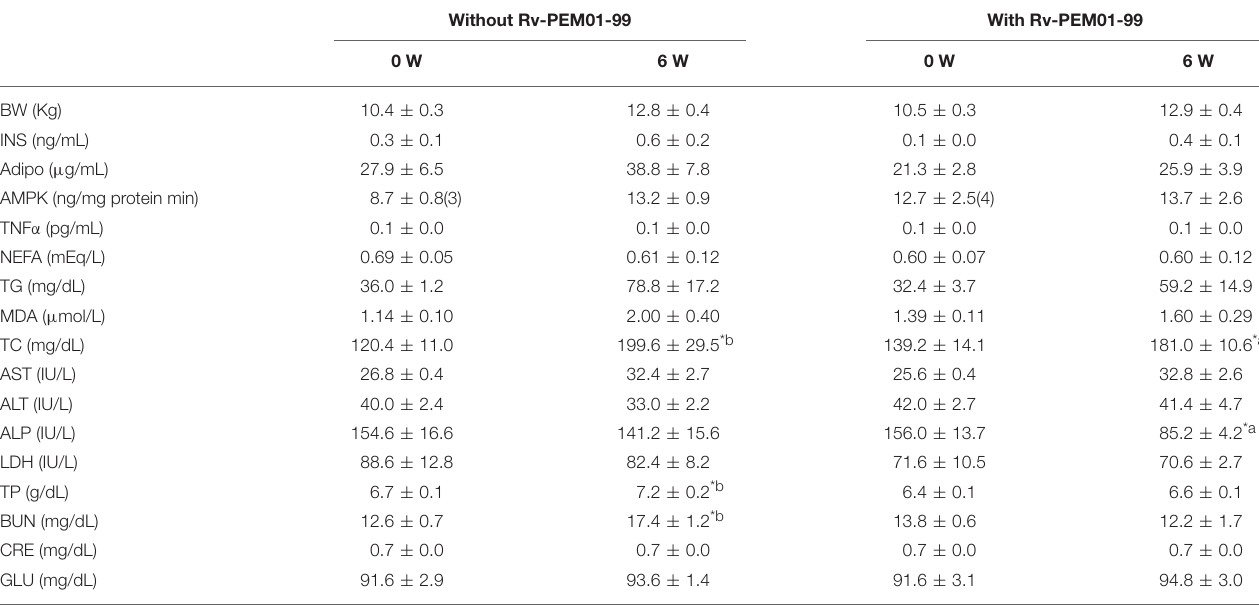
TABLE 2 | Changes in biomarker levels in obese dogs fed with high fat